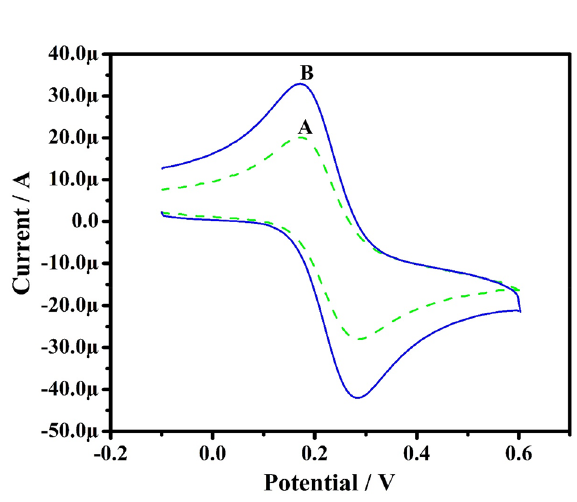
Figure 3. CV results of K 4 [Fe (CN) 6 ] at bare CPE (A) and PoOCD/MCPE (B) at a SR 100 mVs −1